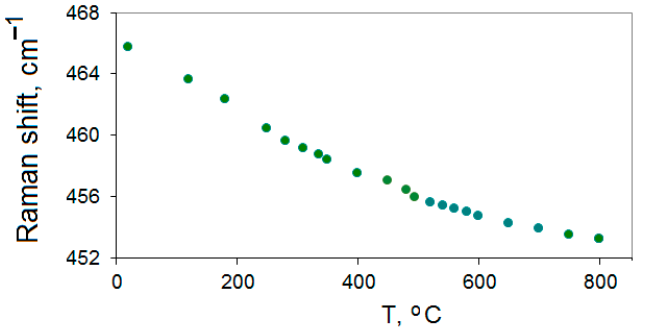
Figure 4. Temperature dependence of the vibration band in the region of 460 cm − 1 of the 0.85FLiNaK–0.15CeF 3 fluoride composition obtained in the cooling mode. 0.85FLiNaK–0.15CeF 3 fluoride composition obtained in the cooling